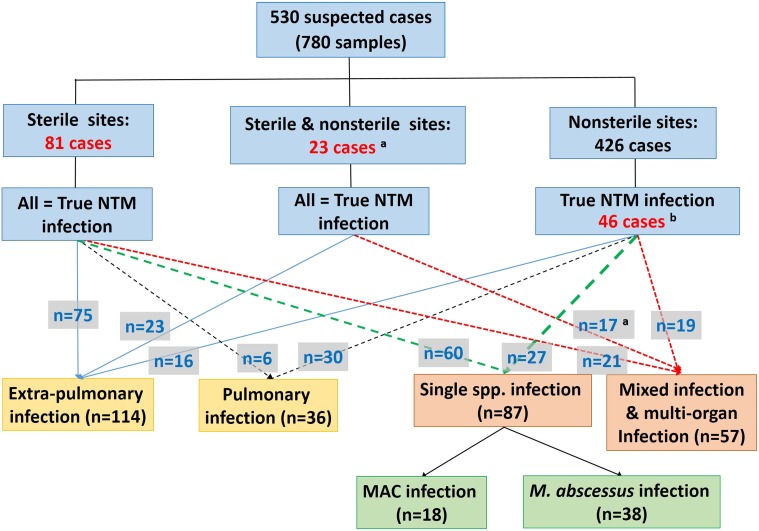
Studied populations and group classifications.aNTMs were isolated from both sterile and nonsterile samples in six out of 23 cases, but no diagnosis and treatment data support the view that isolates from the nonsterile sites have contributed to infection. bThese cases were regarded as true NTM infections on the basis of their initial diagnoses and records of receiving relevant treatment (41 cases), or by only having a history of receiving relevant treatment (five cases).